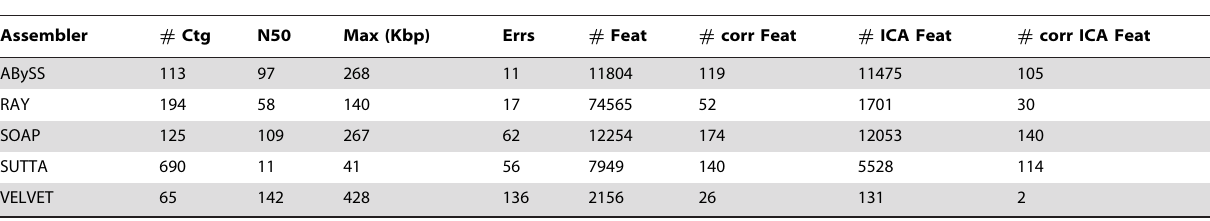
Table 4. Assembly Comparison Real Short Reads: E. coli 130 | .